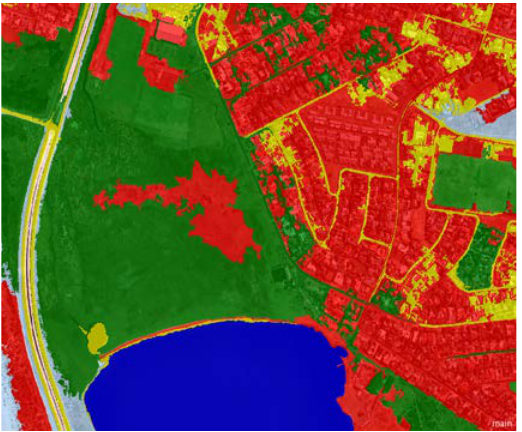
Figure 6: Object-based classification using the Nearest Neighbour method